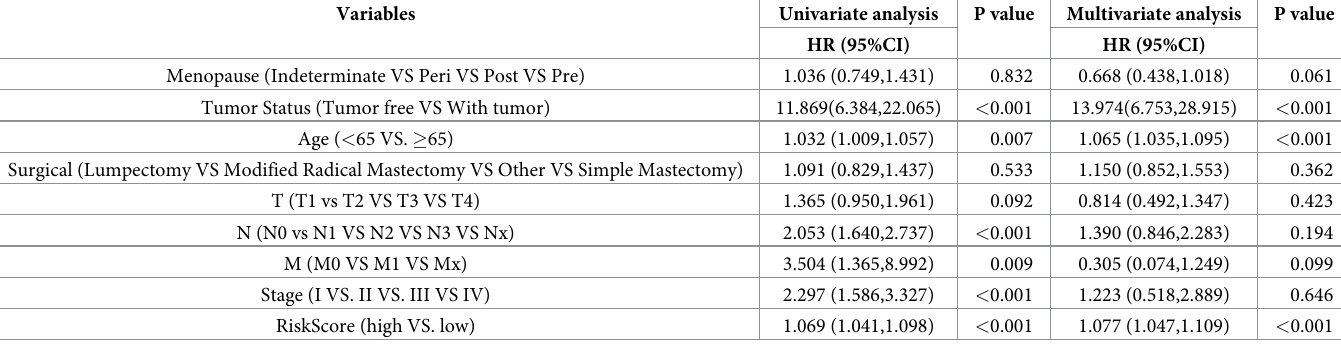
Table 3. Cox proportional regression analysis of the correlation of clinical factors and the lncRNA signature risk score with OS in BCa